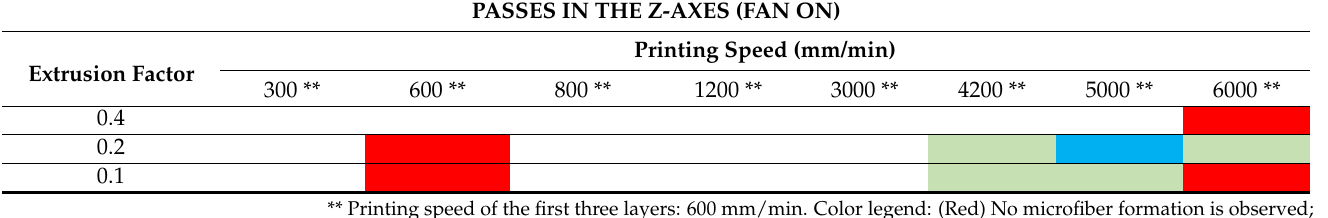
Table A3. Summary of results with the fan switched on, doing passes in the Z-axes with a low extrusion